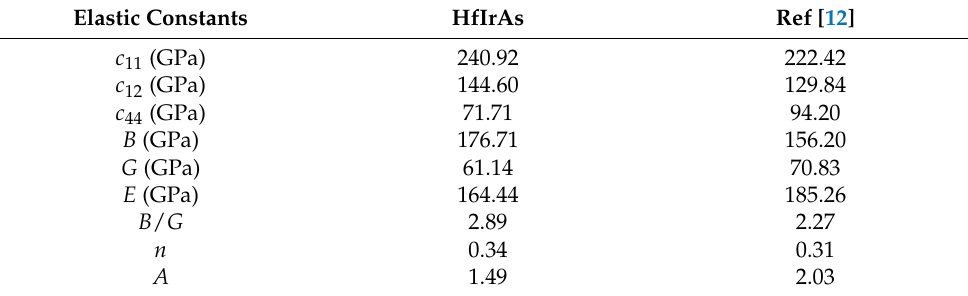
Table 2. Table of elastic constant of HfIrAs. Elastic